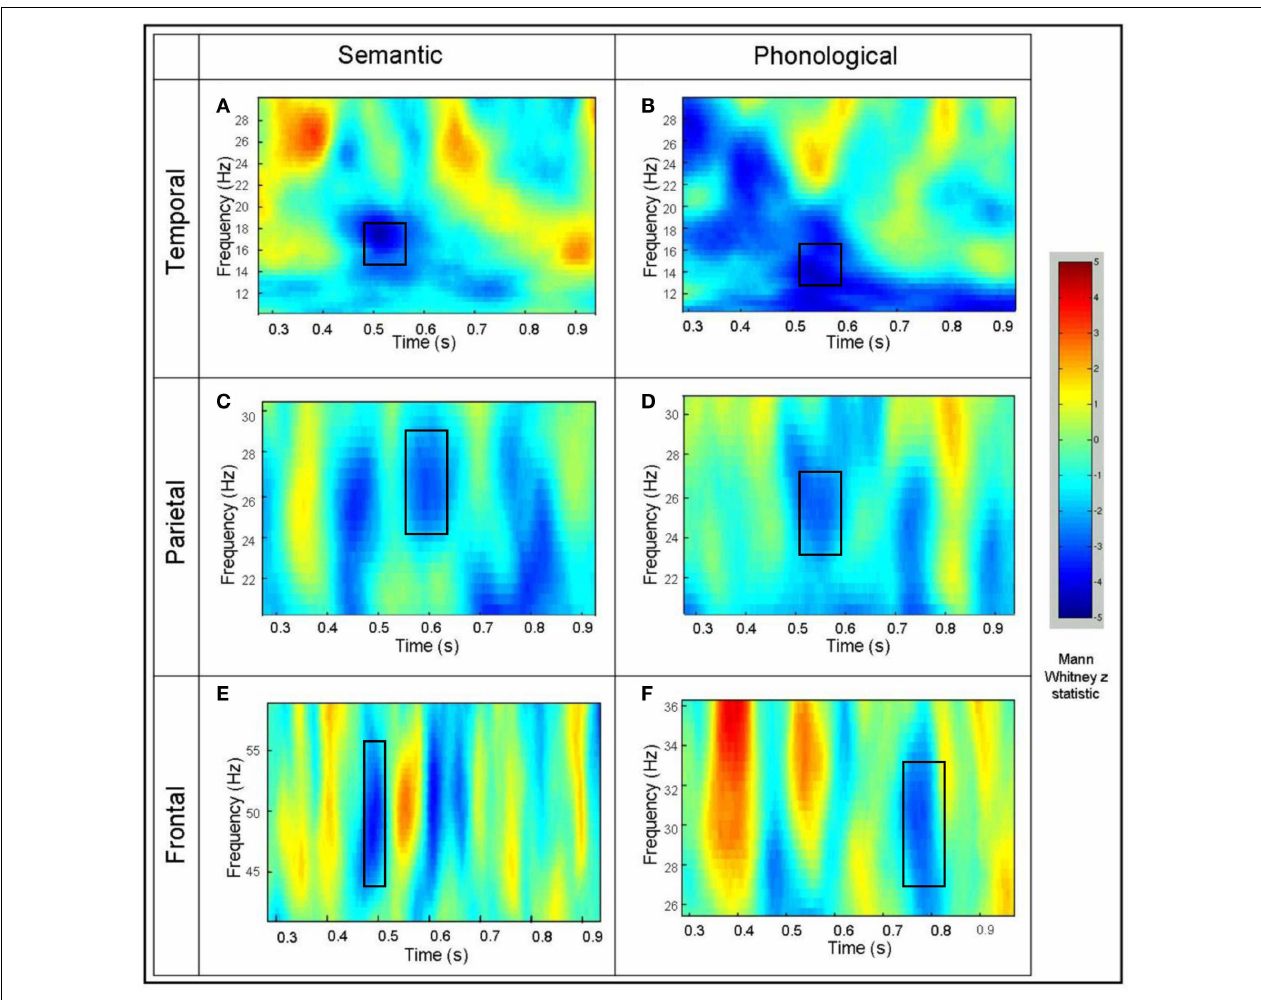
effect for the semantic task and (D) the phonological task. (E) The left superior frontal effect for the semantic task and (F) the phonological task.The color represents the Mann–Whitney Z statistic for comparisons between the task and the prestimulus